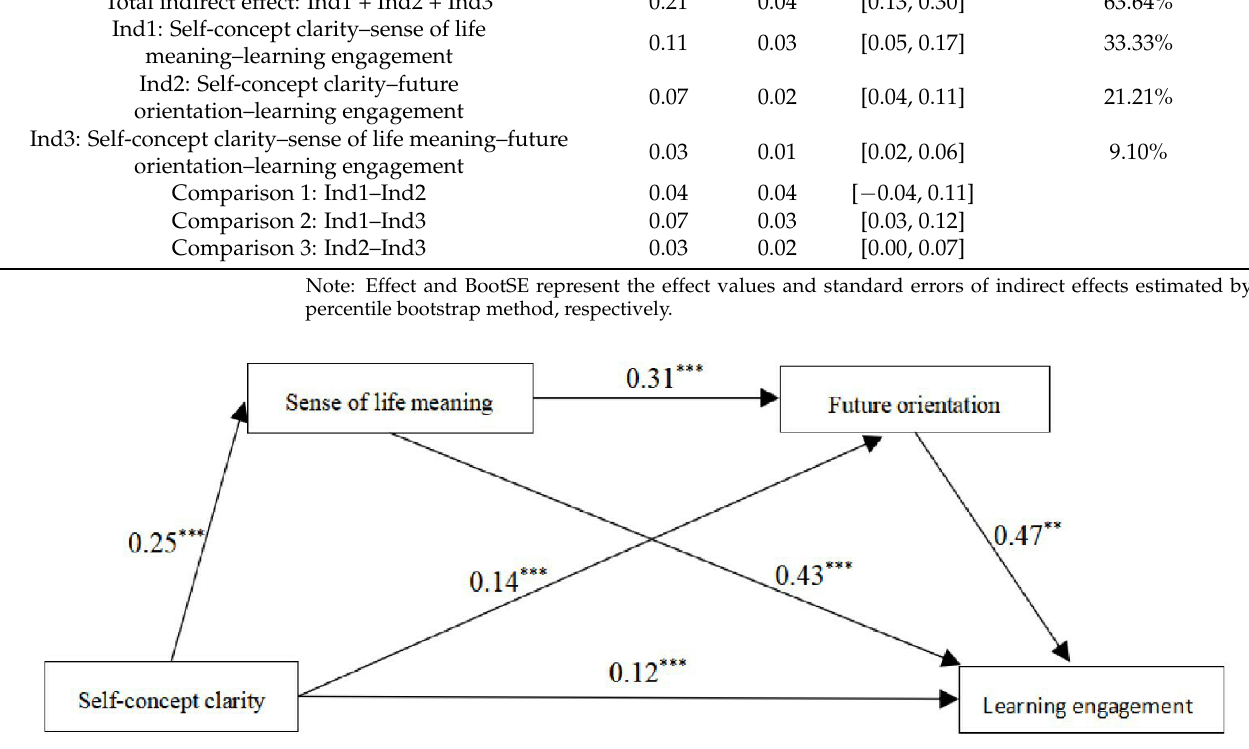
Figure 2. A multiple mediation model for the association between self-concept clarity and learning engagement. ** p < 0.01; *** p < 0.001. engagement. ** p < 0.01; *** p <